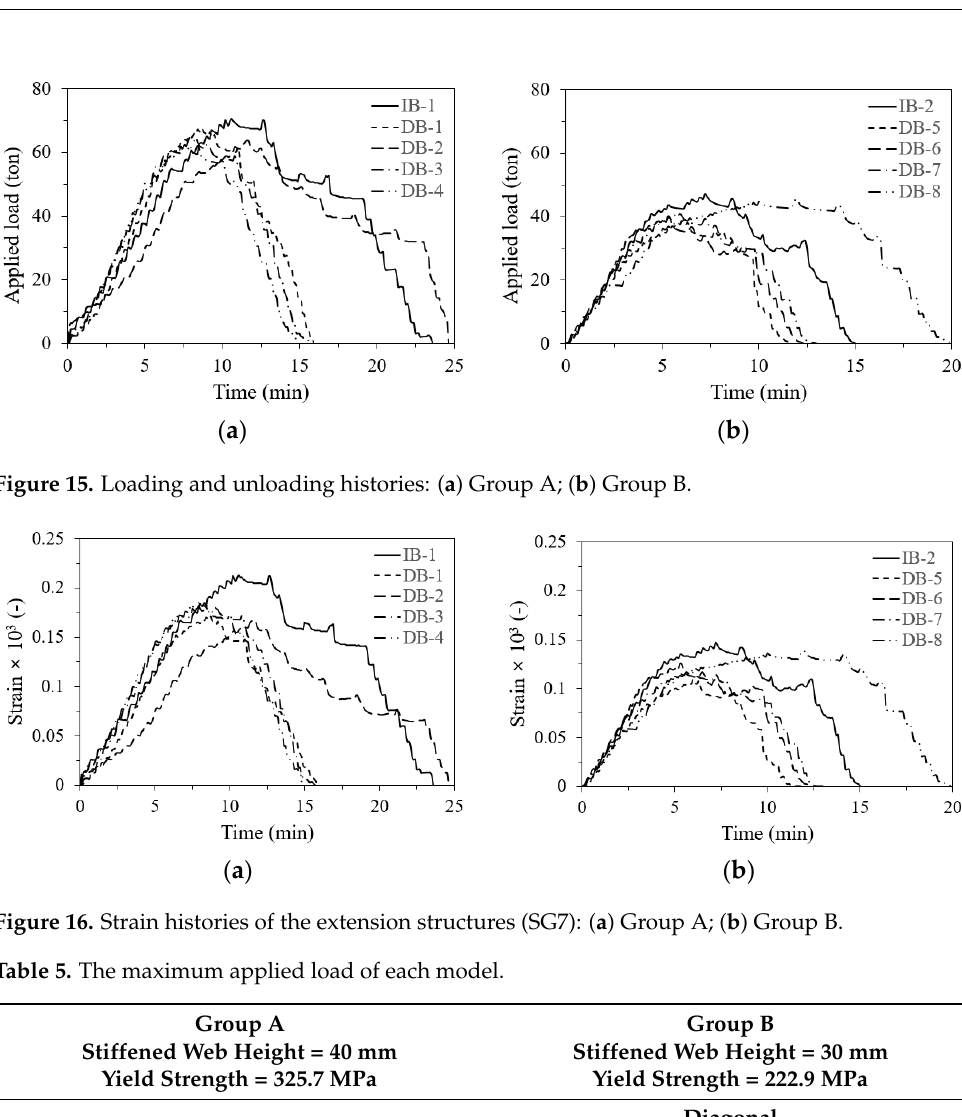
Figure 14. Deformed shapes of the longitudinal stiffeners—model DB-7: ( a ) deck; ( b ) damaged